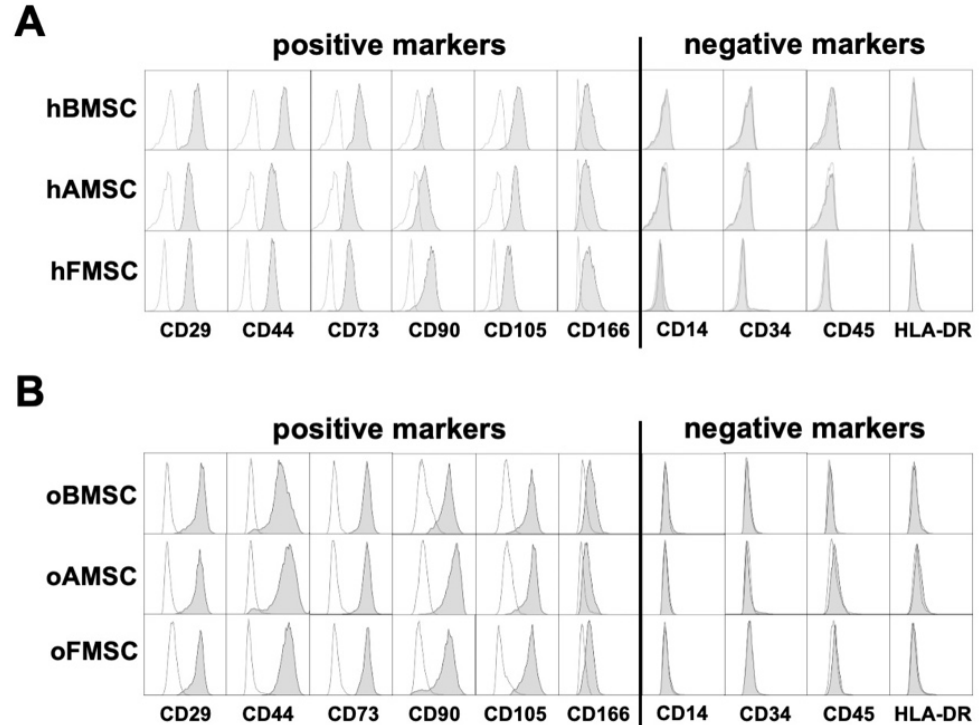
Figure 2. MSCs from human and ovine sources displayed common positive and negative surface markers. Surface marker expression analysis of ( A ) human and ( B ) ovine MSCs from the three corresponding sources was performed using flow cytometry. Representative histograms of 3-8 donors per source. AMSC: adipose tissue-derived mesenchymal stromal cells, FMSC: femoral-derived mesenchymal stromal cells, BMSC: bone marrow-derived mesenchymal stromal cells.